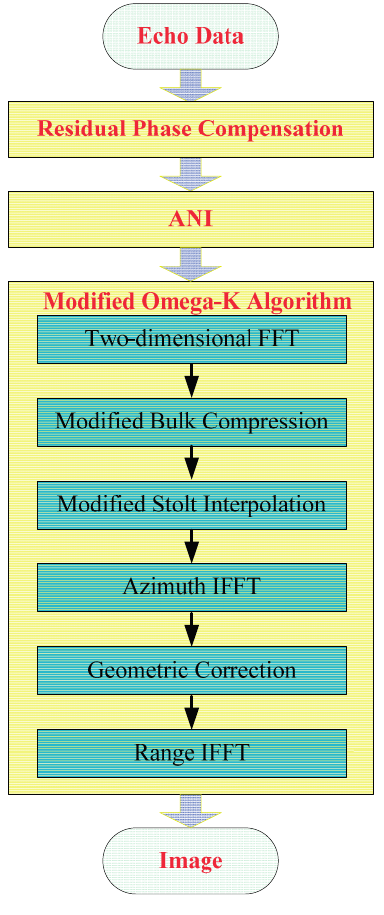
Figure 6. Block diagram of the modified Omega-k algorithm based on